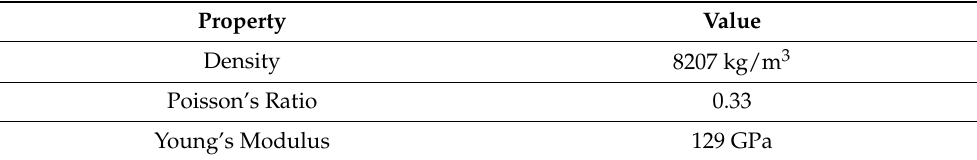
Figure 3. Geometry snapshots of the numerical model designed in Abaqus: ( a ) cylindrical pipe with partitions visible for excitation and sensing locations, ( b ) geometry with only edges, ( c ) sketch of the cylinder radial base, and ( d ) crack formation and dimensions. Table 1. Elastic and mechanical properties of steel material in the Abaqus